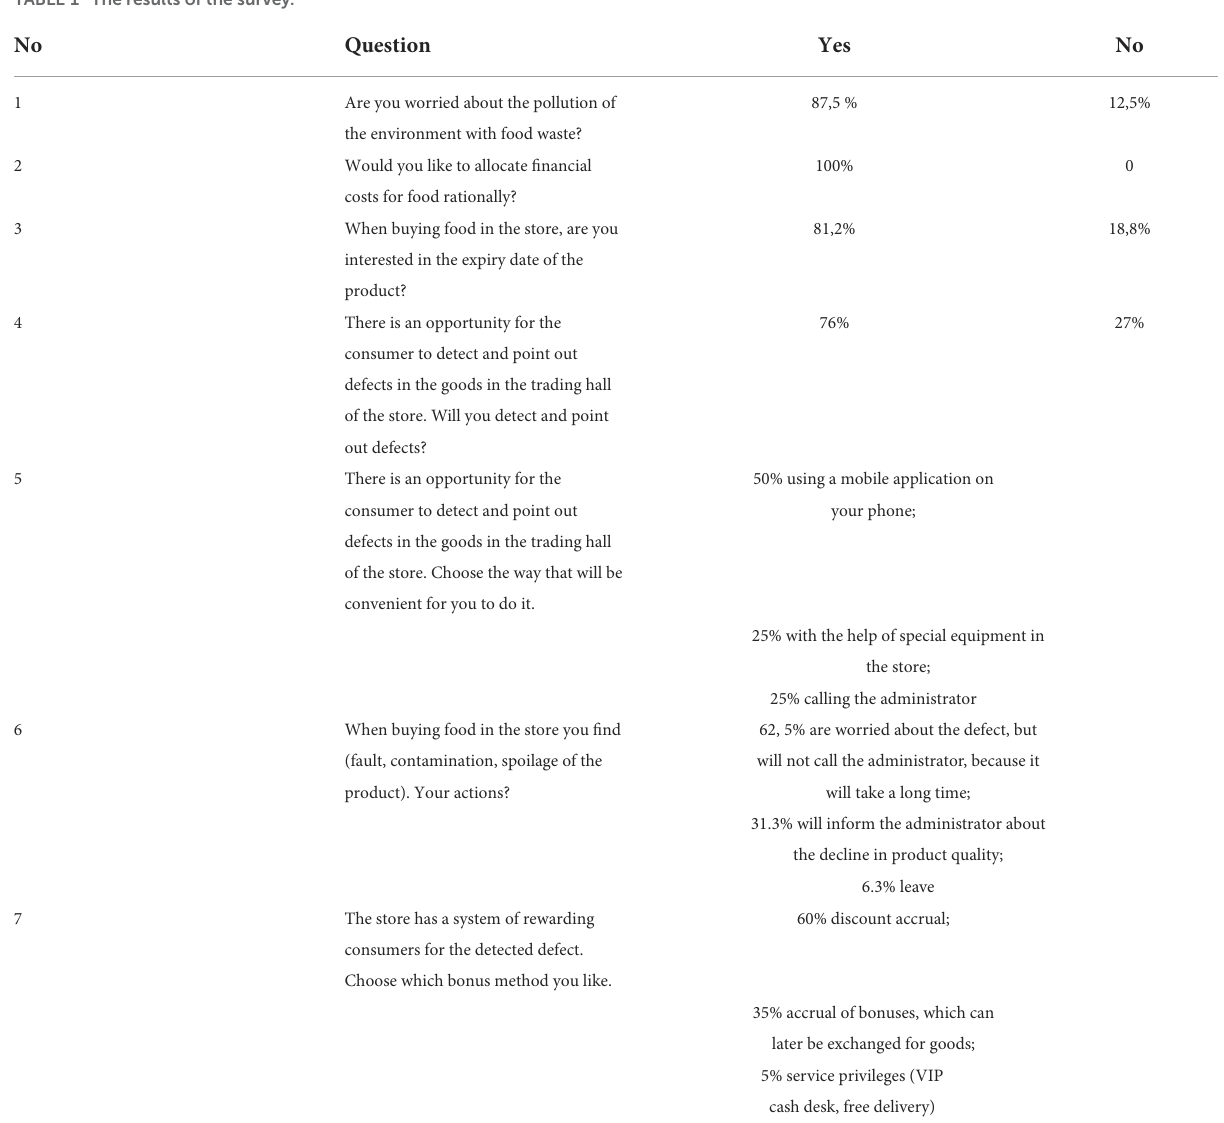
TABLE 1 The results of the